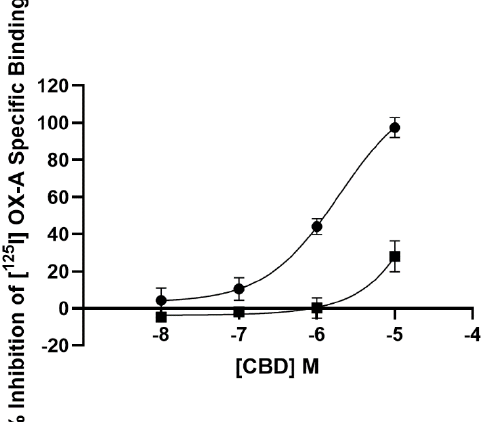
Figure 1. Competition for [ 125 I] orexin-A binding to OX1R-CHO cells (filled circle) and OX2R-CHO cells (filled square) by CBD. Data are the mean of three independent experiments; vertical lines show standard deviation.